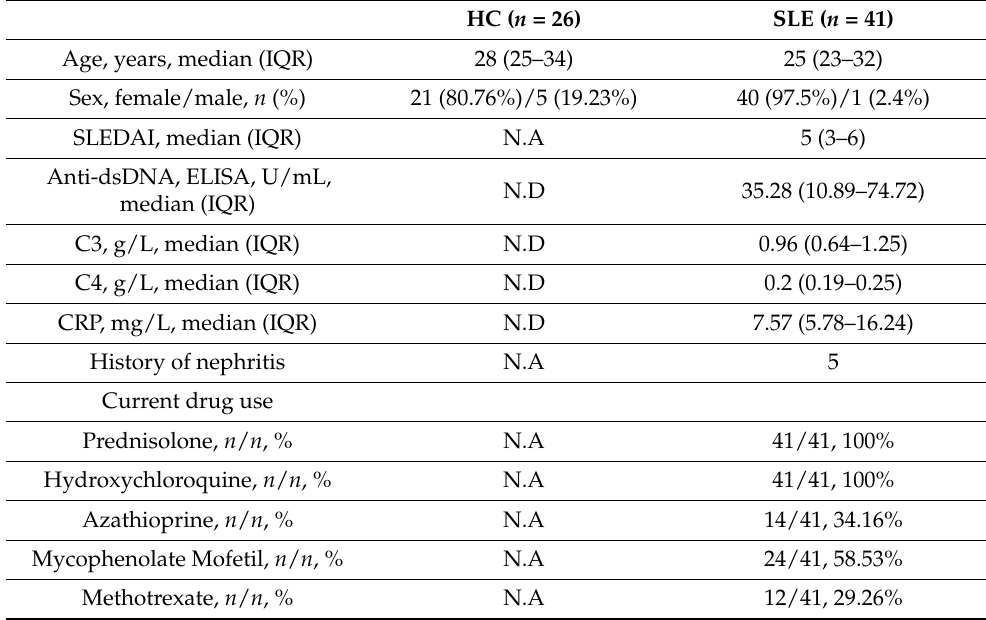
Table 1. Clinical and demographic characteristics of SLE patients and healthy